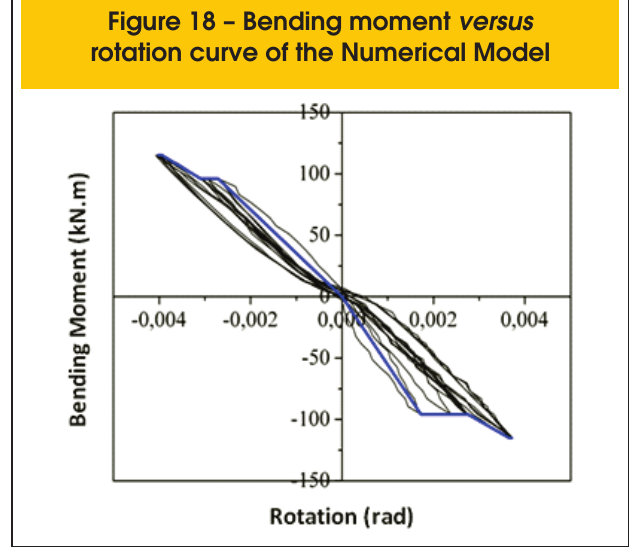
Figure 18 – Bending moment versus rotation curve of the Numerical Model